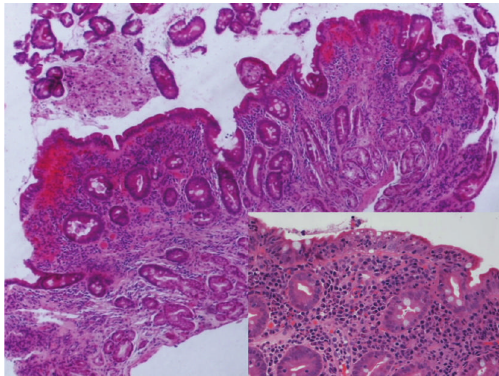
Figure 2: Inguinal lymph node biopsy illustrating anaplastic large cell lymphoma (ALCL): Lymph node replaced by nodules of proliferating large, pale, anaplastic-looking tumour cells of lymphoid origin (H&E, × 80 original magnification) positive with immuno-labelling for Alk-1, CD30 and EMA (insets; × 150 original